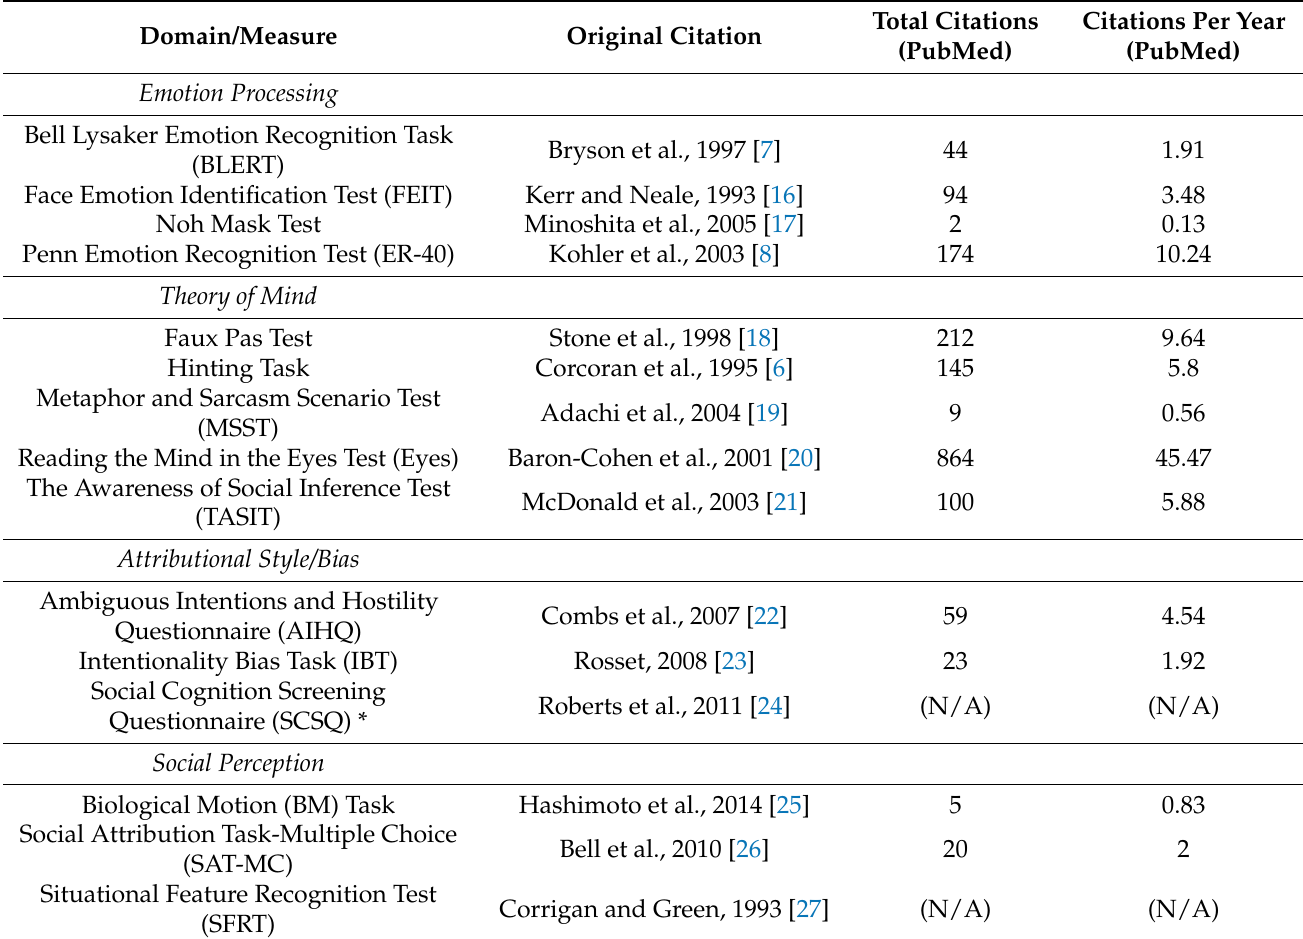
Table 1. Candidate social cognition